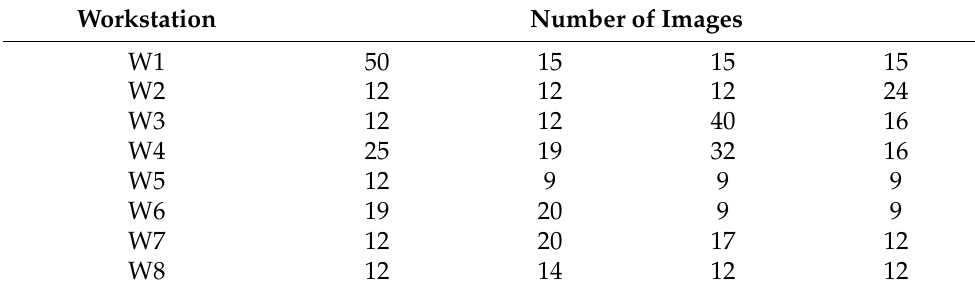
Figure 3. Sample images of the dataset. Table 3. Number of images for each class of